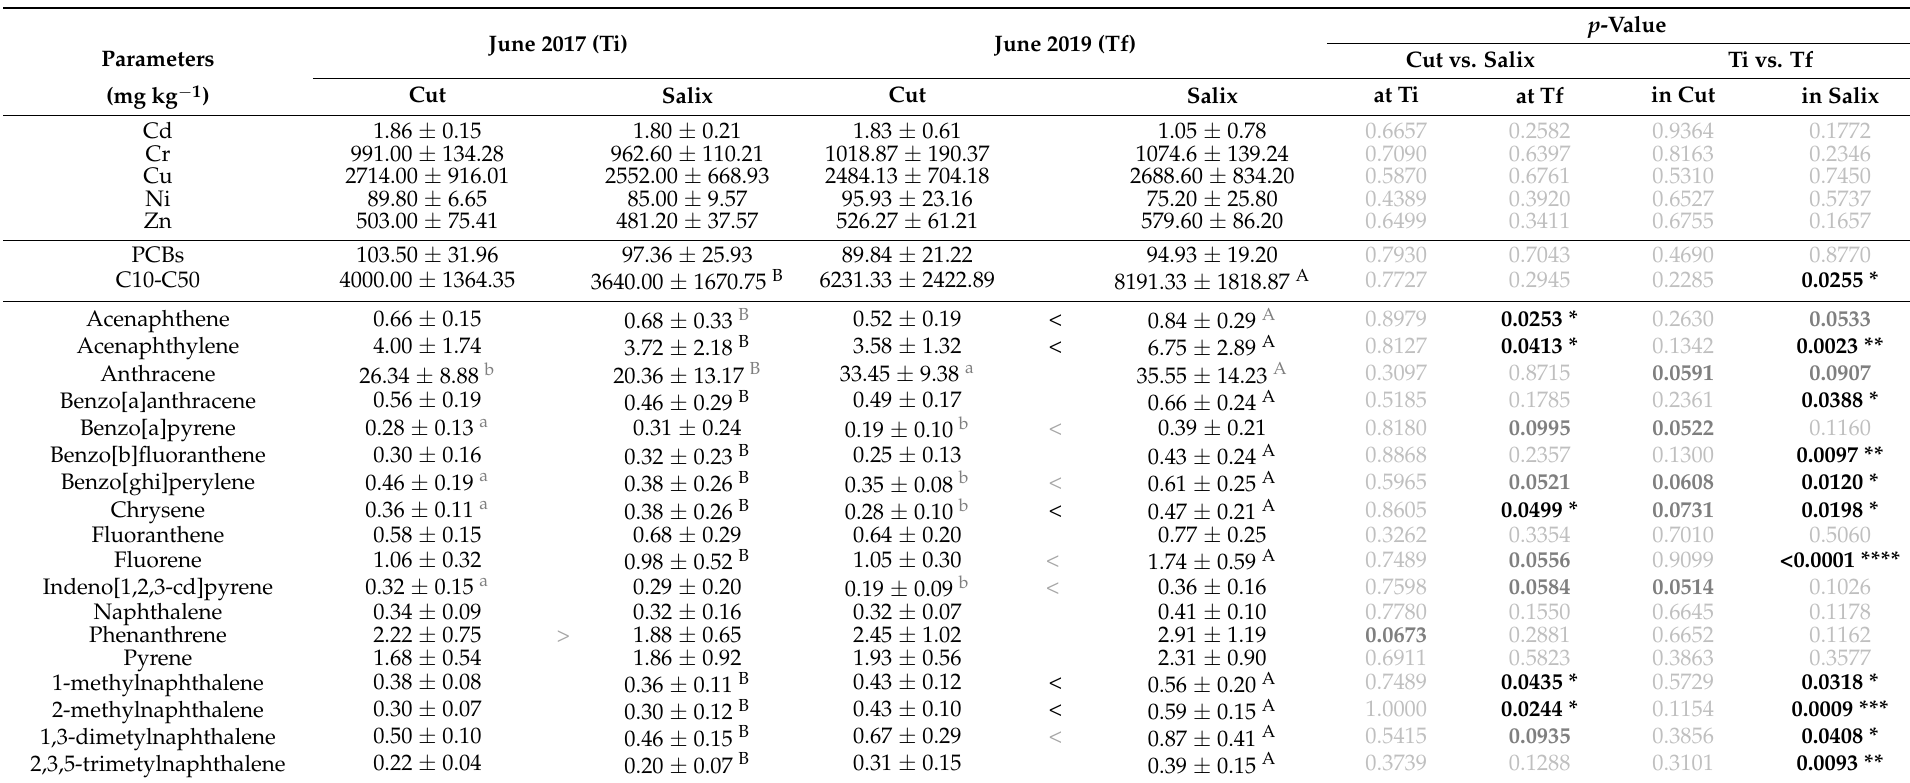
Table 2. Comparison of soil contaminant concentrations between treatments at each sampling time and between sampling times in each